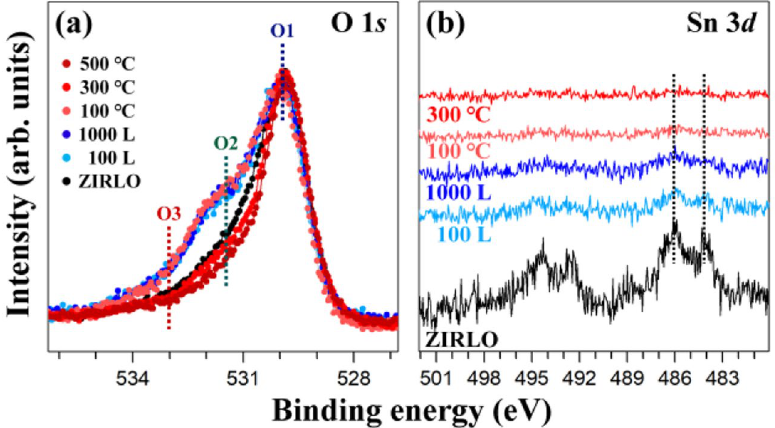
Figure 3. ( a ) O 1 s and ( b ) Sn 3 d HRPES spectra of ZIRLO measured before the deposition of H 2 O, after the adsorption of 100 L and 1000 L H 2 O, and after annealing at 100 °C, 300 °C, and 500 °C subsequent to the deposition of 1000 L H 2 O. O 1 s HRPES spectra in ( a ) were normalized using O1 peak at 530.0 eV. Sn 3 d HRPES spectra obtained after annealing at up to 300 °C are exhibited in. ( b ) The dashed lines express the positions of the binding energy of each